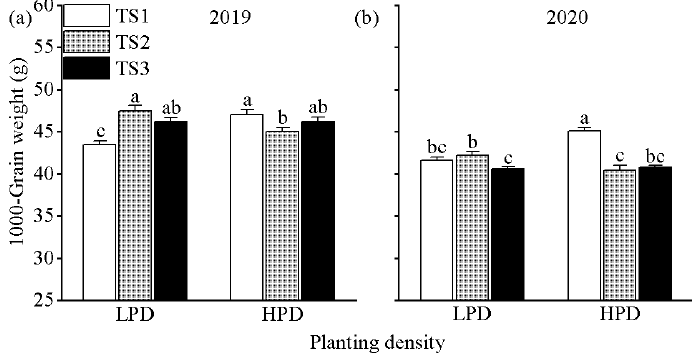
Figure 3. Effects of the combinations of planting density and method of tillage and sowing on ( a , b ) 1000-grain weight at the maturity stage in the 2019 and 2020 seasons. Data are presented as means ± standard errors, and the bars above the columns are standard errors. The different letters on the bars indicate significant differences at the 0.05 probability level.